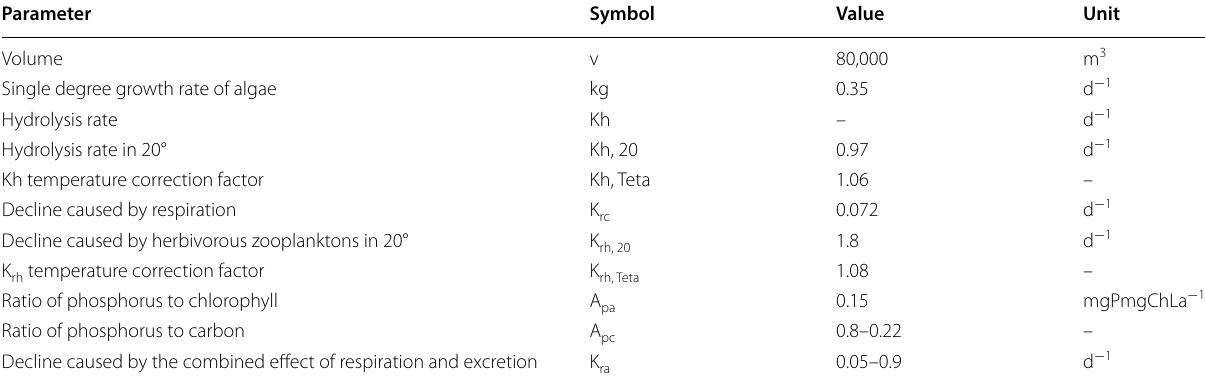
Table 2 Calibration coefficients, rates and parameters in the facultative pond model